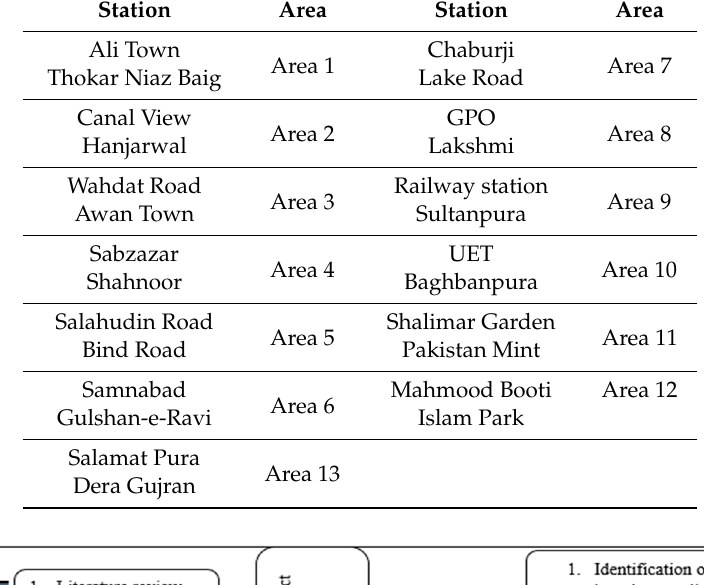
Table 1. Orange Line Metro Train (OLMT) areas and stations.